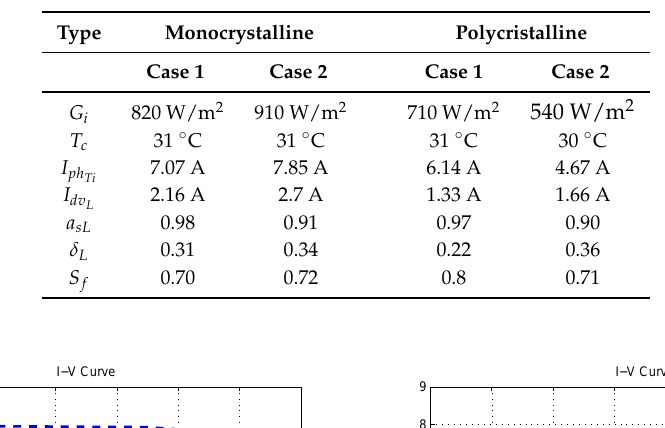
Figure 16. Experimental setup for model validation and image processing. Table 5. Shading factor results for the PV modules under testing.